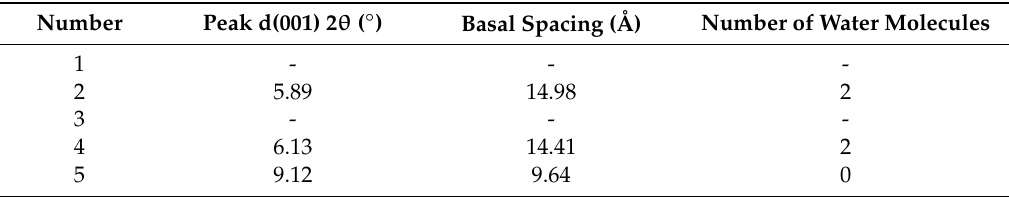
Table 4. XRD results of montmorillonite samples.